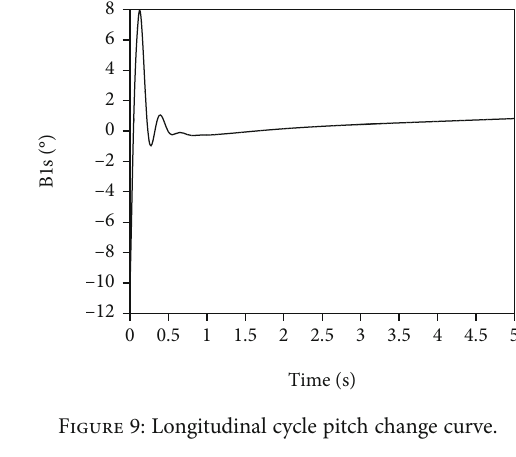
Figure 9: Longitudinal cycle pitch change